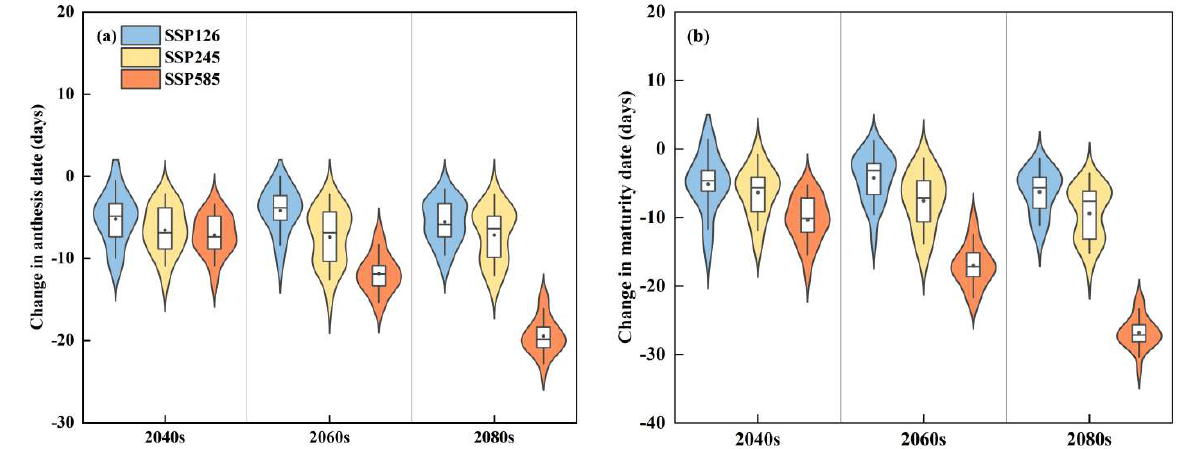
Figure 5. Simulated change in a rice growth period in the 2040s, 2060s, and 2080s under SSP126, SSP245, and SSP585 scenarios relative to 2000–2019 using six GCMs for Qing’an station on the Songnen Plain of China. The box boundaries indicate the 25th and 75th percentiles; the black line and dot within the box mark the median and mean, respectively; and whiskers below and above the box indicate mean +1.5 SD and mean − 1.5 SD, respectively.